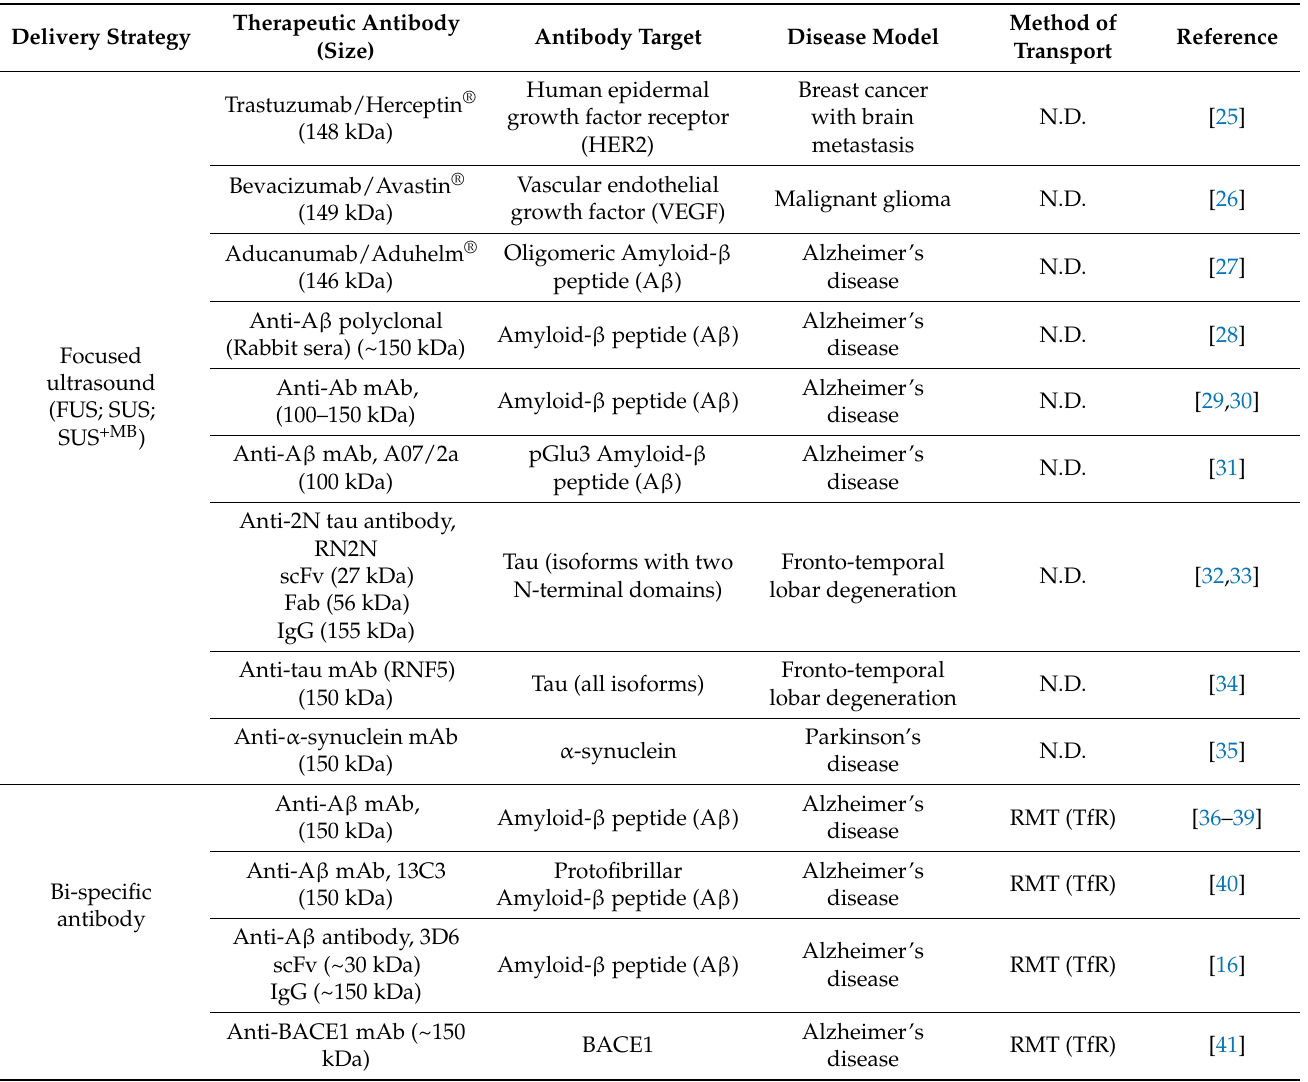
Table 1. Strategies that have enhanced therapeutic antibody delivery to the